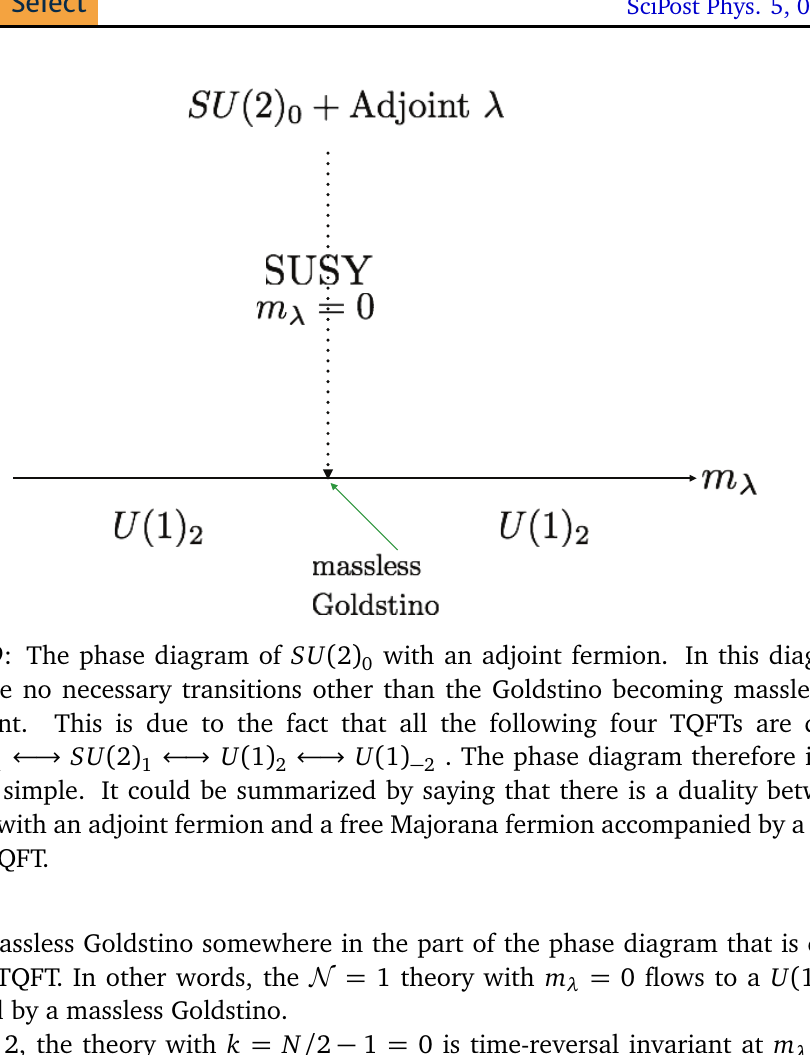
with an adjoint fermion. In this diagram 0